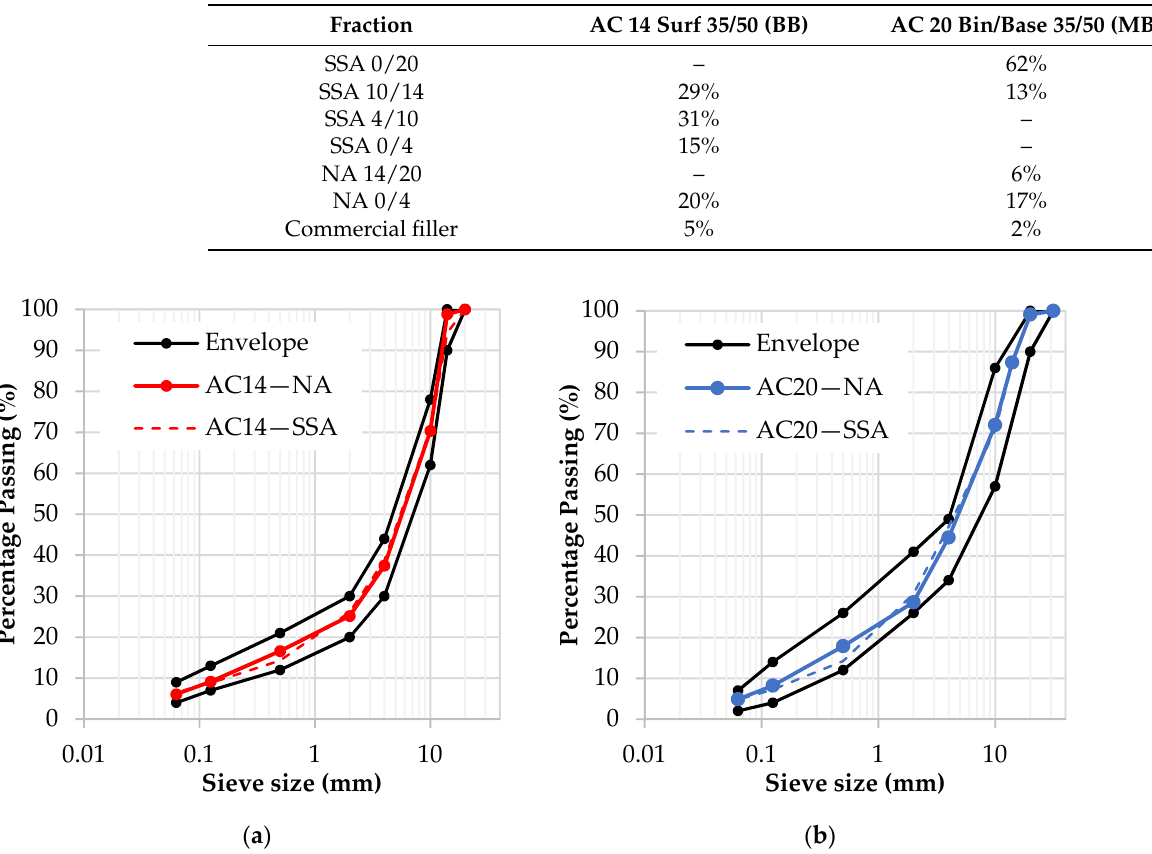
Figure 7. Grading curve adjustments for the conventional asphalt mixtures with natural aggregates (NA) and the selected asphalt mixture with 75% SSA: ( a ) AC 14; ( b ) AC 20.